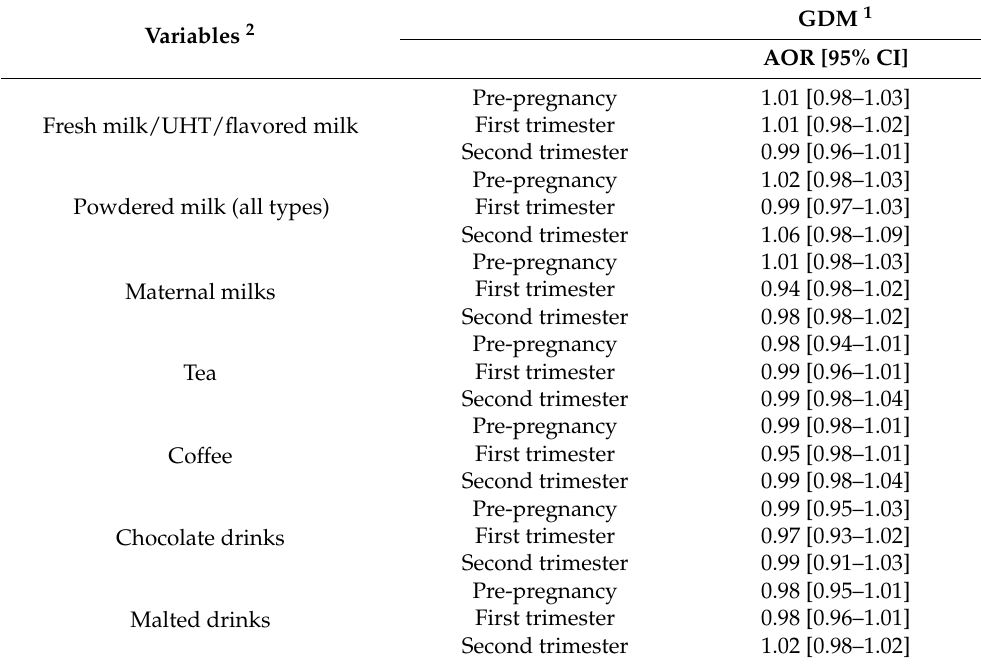
Associations between types and quantity of beverages and gestational